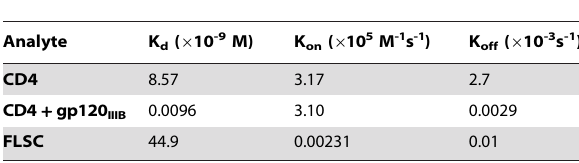
Table 3. Affinities and binding kinetics of MAb